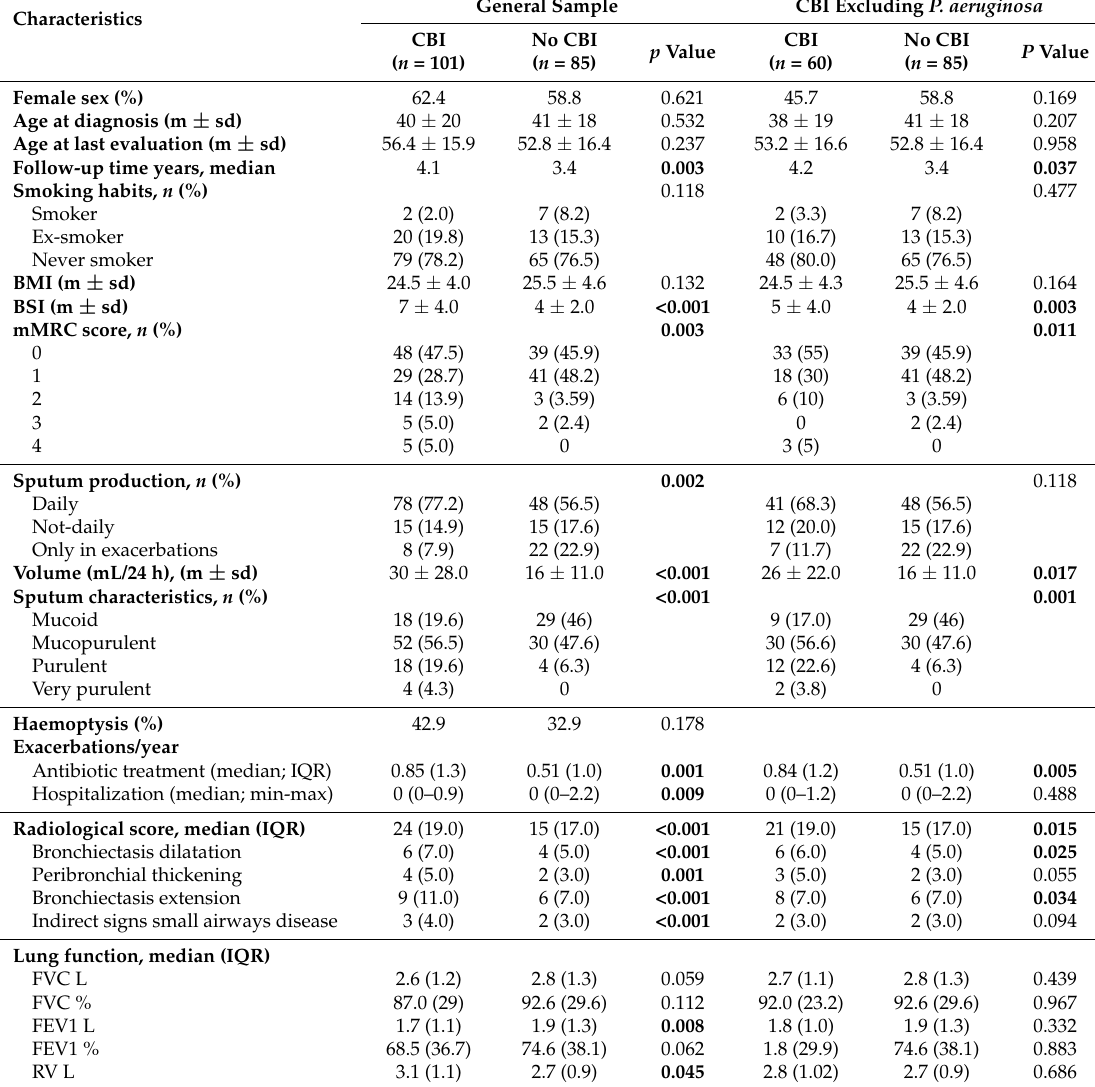
Table 3. Patient characteristics and differences between